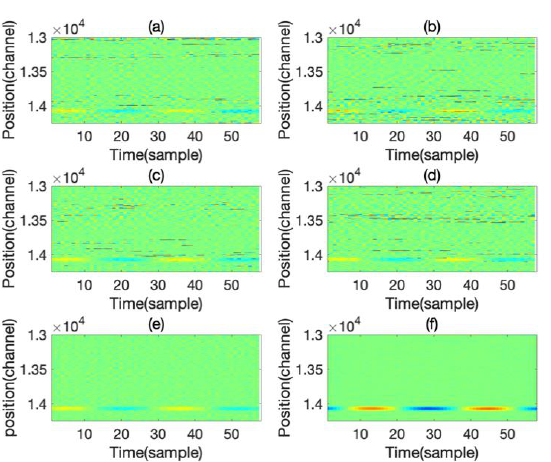
Figure 3. The time differential phase waterfall demodulated by ( a ) 1st frequency of X polarization; ( b ) 2nd frequency of X polarization; ( c ) 1st frequency of Y polarization; ( d ) 2nd frequency of Y polarization; the time differential phase ( e ) and phase ( f ) waterfall synthesized by a “2-polarization-2-frequency”.